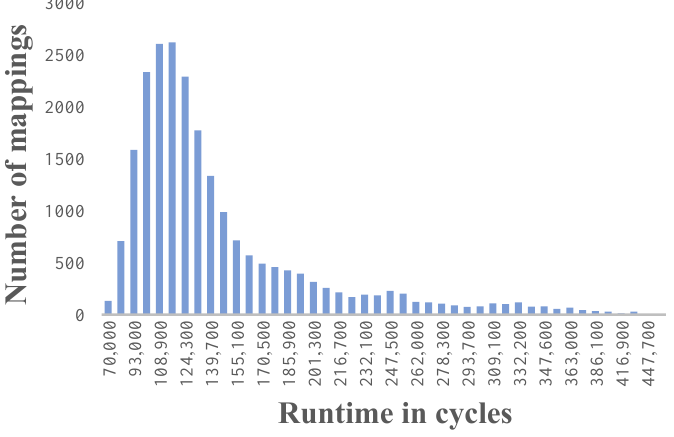
Figure 1. Performance comparison of different mapping schemes.